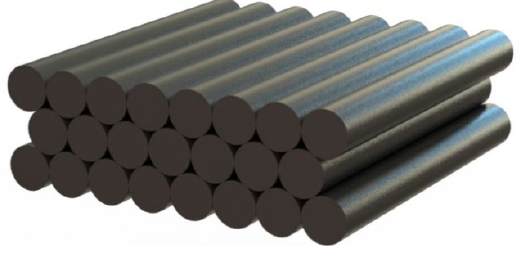
Figure 2. Scheme of the geometrical structure of a flatbed of round bars with a staggered arrangement.